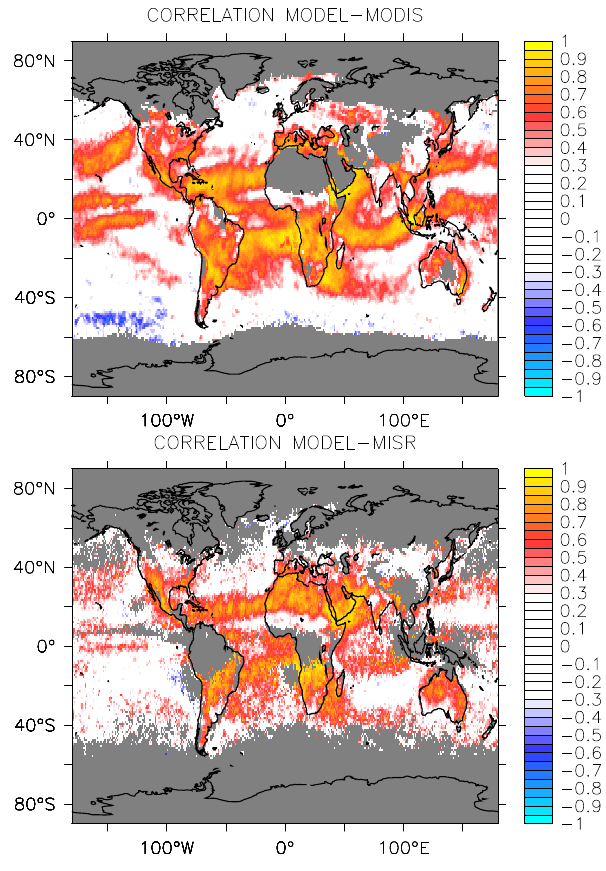
Fig. 3. Correlation ( R ) between model results and MODIS and MISR observations (level 3 product) of AOD. In grey the regions with less than 24 observations/months present during the years